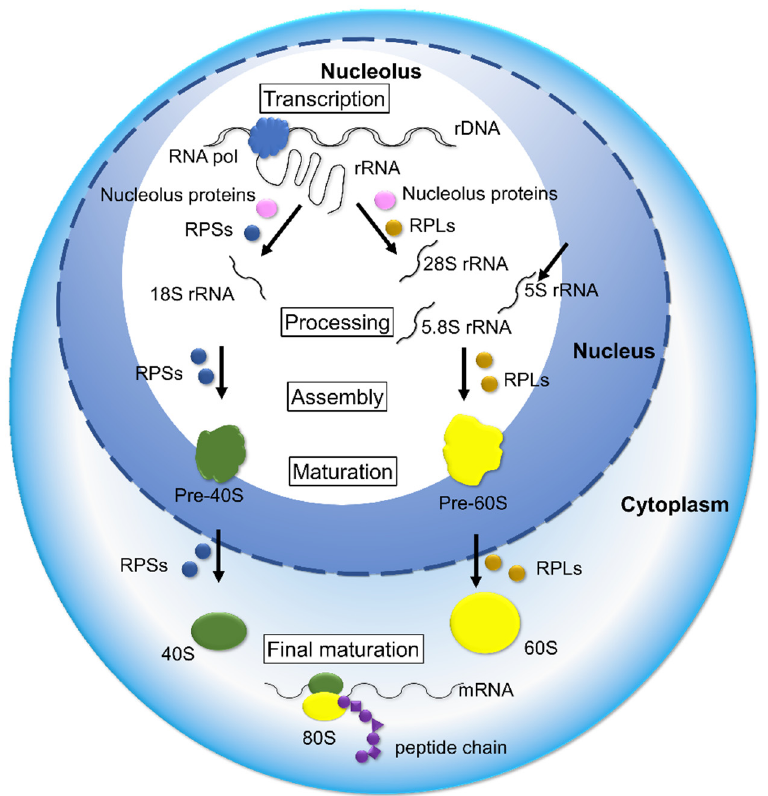
Figure 4. In ribosome biogenesis, many molecules participate in multiple steps, including rDNA transcription, rRNA processing, nucleolus protein assembly, ribosomal proteins, rRNAs, the maturation of large and small ribosomal subunits, and finally the maturation of 80S ribosome. The deregulation of ribosome biogenesis causes an abundance or shortage of ribosomal proteins, which induce tumor-promotive or -suppressive effects in cancer.